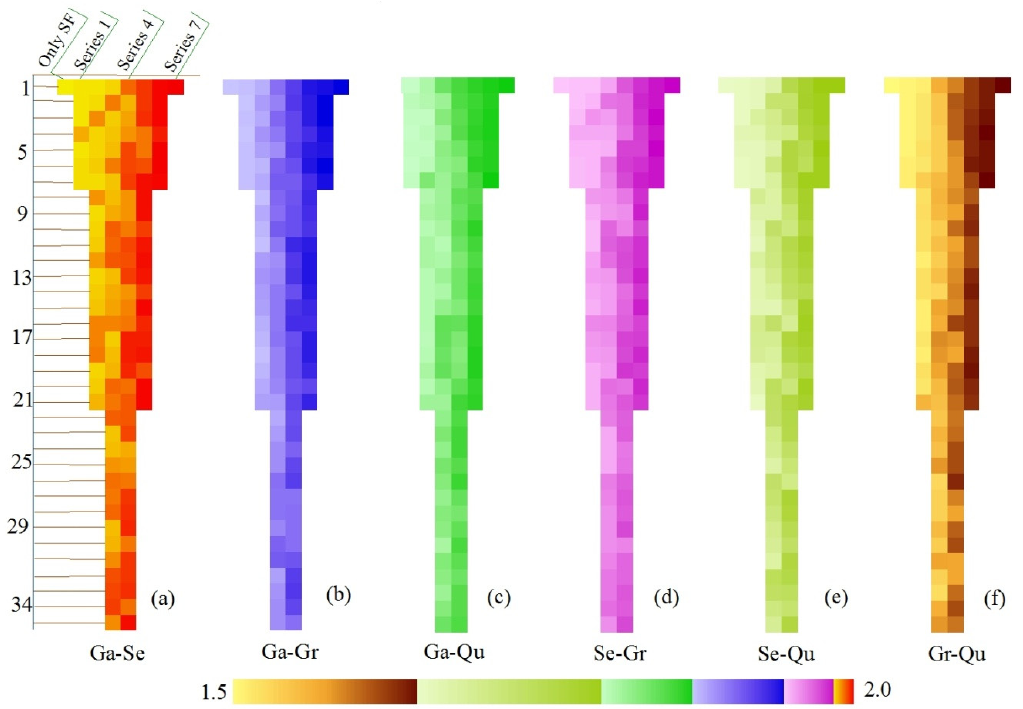
Figure 5. J–M distance of pairwise rocks in different combinations of texture and spectral vectors. Ga is gabbro, Se is serpentinite, Gr is granite, and Qu is quartzose rock. The labels in ( a ) also apply to ( b – f ). Different colors in this figure means the different J–M distance. A darker shades of color means a larger J–M distance. Table 3. Statistically significant J–M distance for the same number of vectors a .